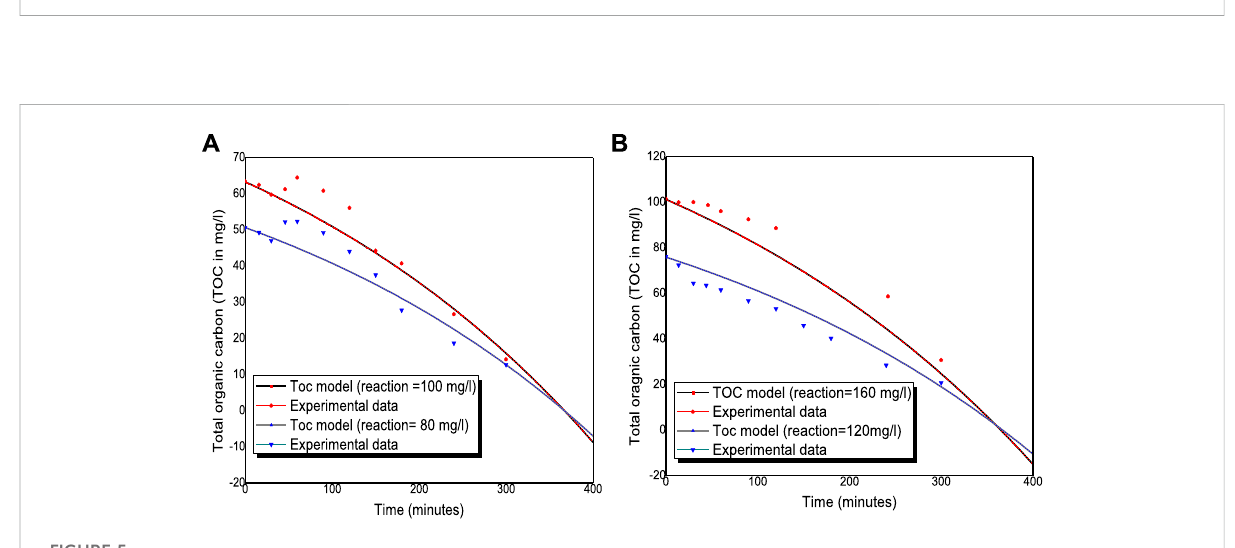
FIGURE 5 Behavior of the model is based on carbon TOC monitoring. In contrast to experimental data, the continuous lines represent the application of the model and the points of the experimental data. (A) Evaluation of the data of a reaction with a C 0 = 100 and 80 mg/l. (B) Evaluation of data from a reaction with a C 0 = 120 and 160 mg/l.